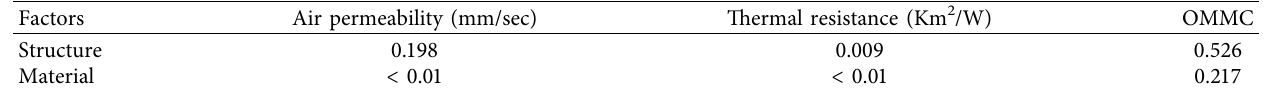
Table 4: p values of signifcant factors for diferent response